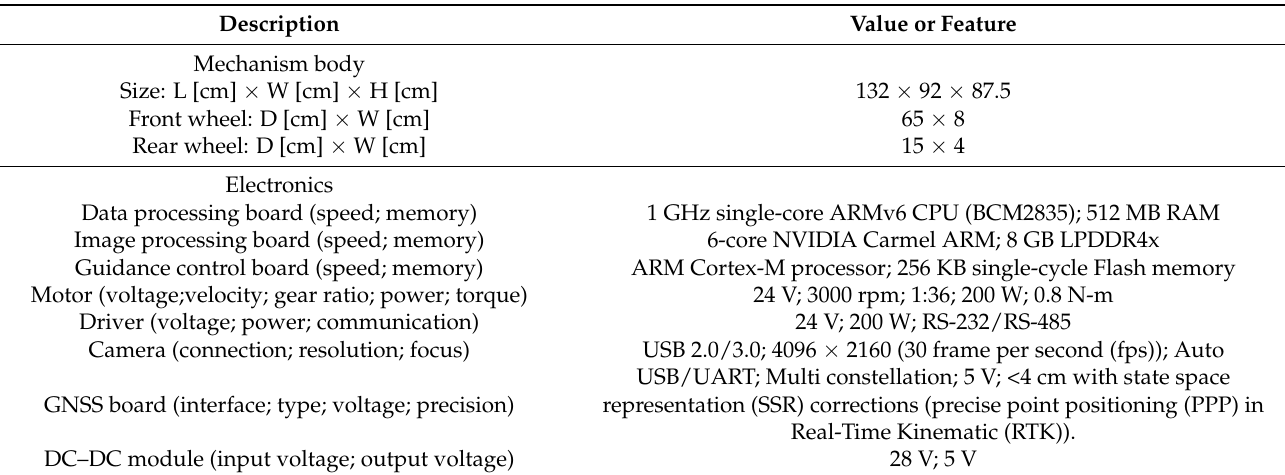
Figure 1. Appearance of the two-wheeled robot trailer. Table 1. Component specifications for the robot trailer.